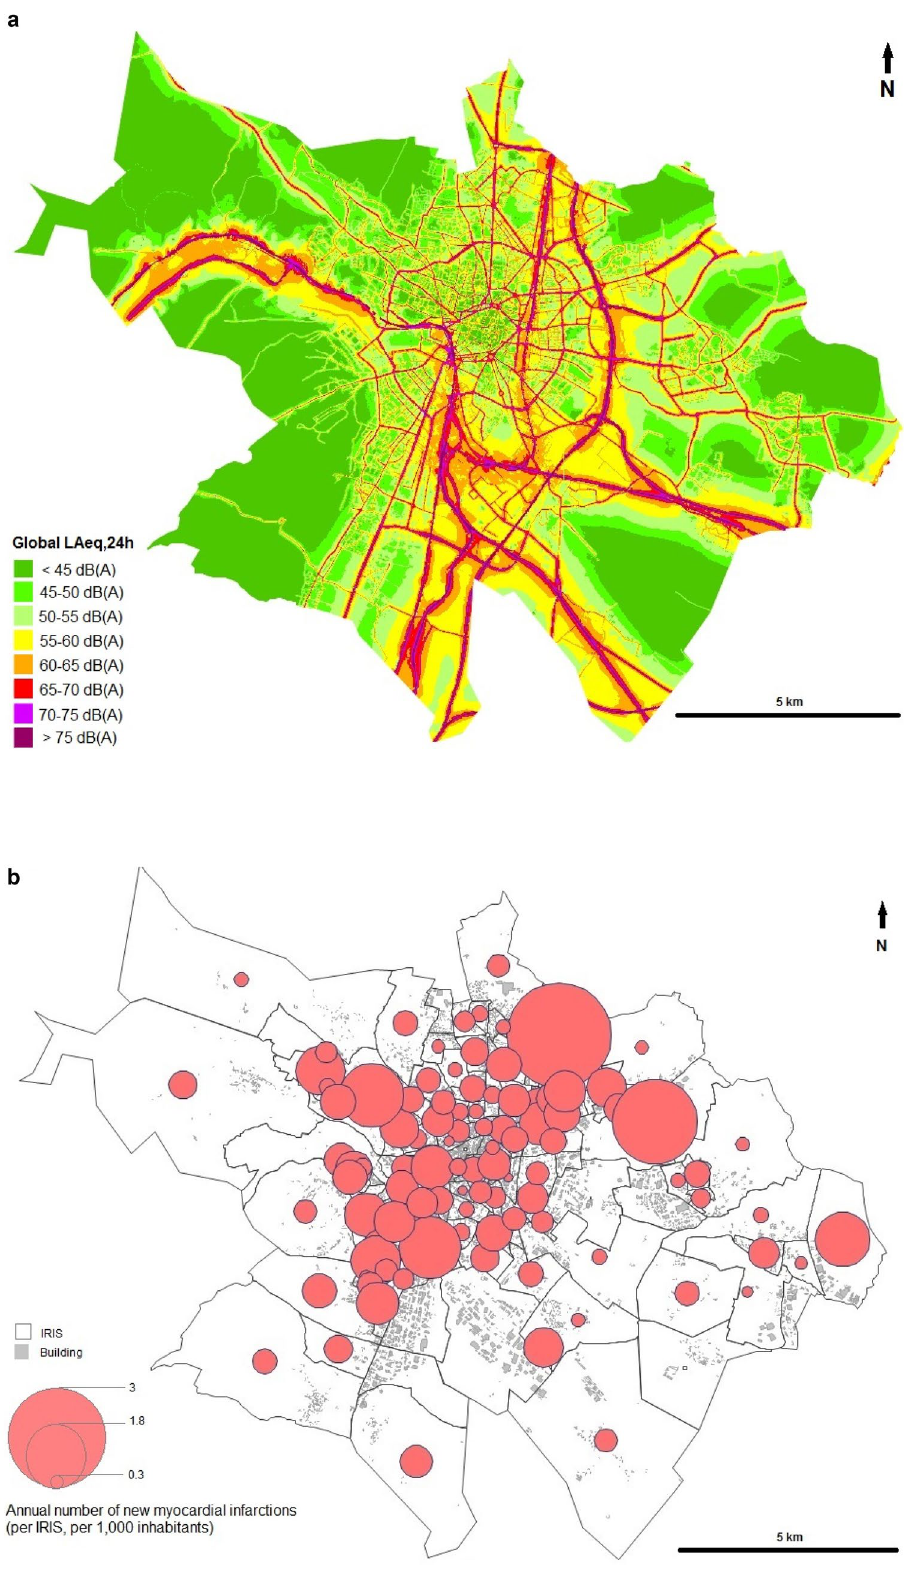
Figure 4. Environmental noise map (global L Aeq,24 h ) and spatial distribution of the observed cases of myocardial infarction. ( a ) Environmental Noise map (global L Aeq,24 h ). ( b ) Annual number of new myocardial infarctions according to the IRIS population size (per 1000